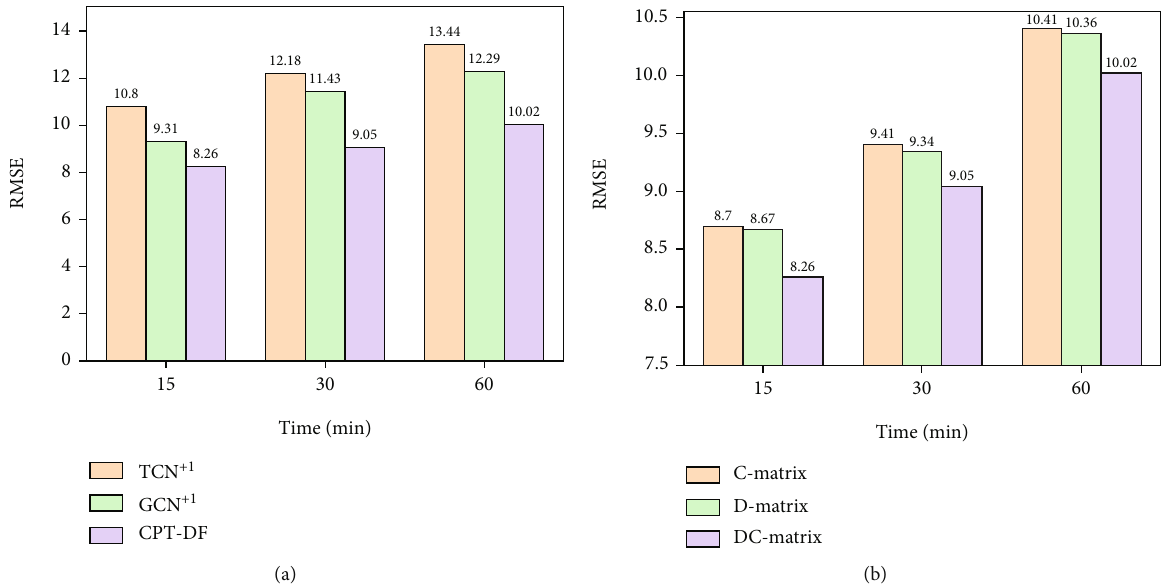
Figure 16: (a) Model improvement before and after comparison. TCN +1 represents the prediction model after removing the spatial module; GCN +1 represents the prediction model after replacing the temporal module. (b) Comparison of prediction accuracy under di ff erent